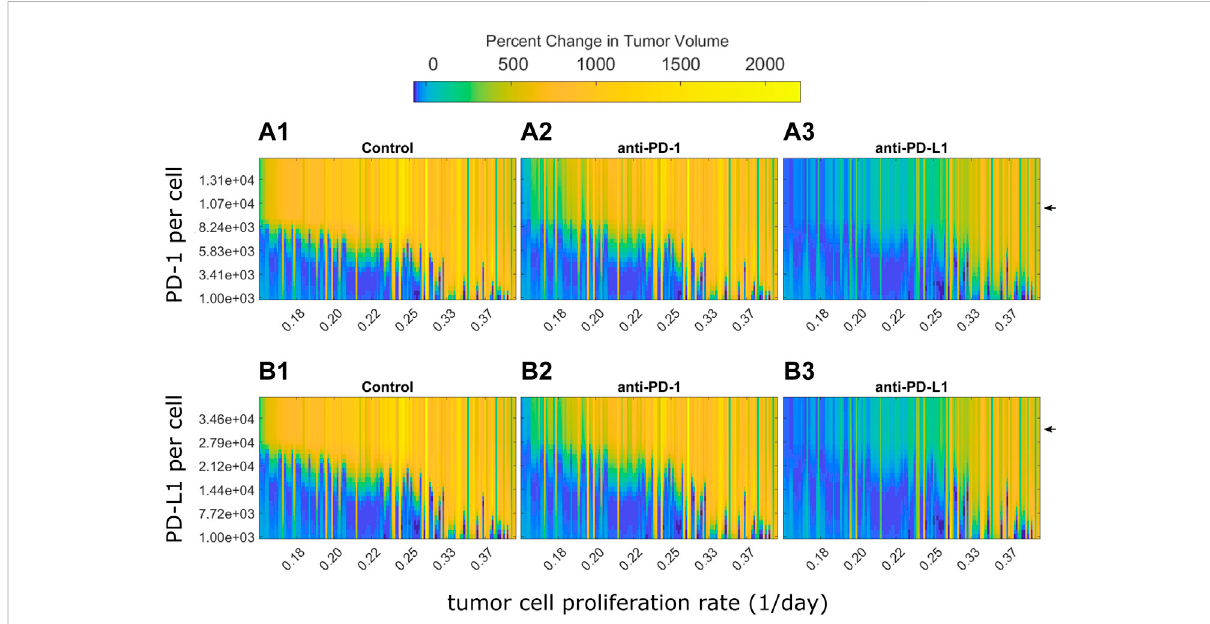
FIGURE 5 Optimal PD-1 or PD-L1 expression level for treatment response differs between individuals. Percent changes in tumor volume 12 days after treatment start for each fi tted mouse with varying PD-1 or PD-L1 expression levels. Mice are arranged on the x-axis according to their estimated tumor cell proliferation rates. PD-1 and PD-L1 expression levels used in QSP model fi tting is marked by black arrows. (A) Change in tumor size from treatment start to 12 days after treatment start for fi tted mice with varying PD-1 per CD8 + T cell for (A1) control, (A2) 10 mg/kg anti-PD-1 Q3D x3, and (A3) 10 mg/kg anti-PD-L1 Q3D x3 simulations. (B) Change in tumor size from treatment start to 12 days after treatment start for QSP model fi tted mice with varying PD-L1 per tumor cell for (B1) control, (B2) 10 mg/kg anti-PD-1 Q3D x3, and (B3) 10 mg/kg anti-PD-L1 Q3D x3